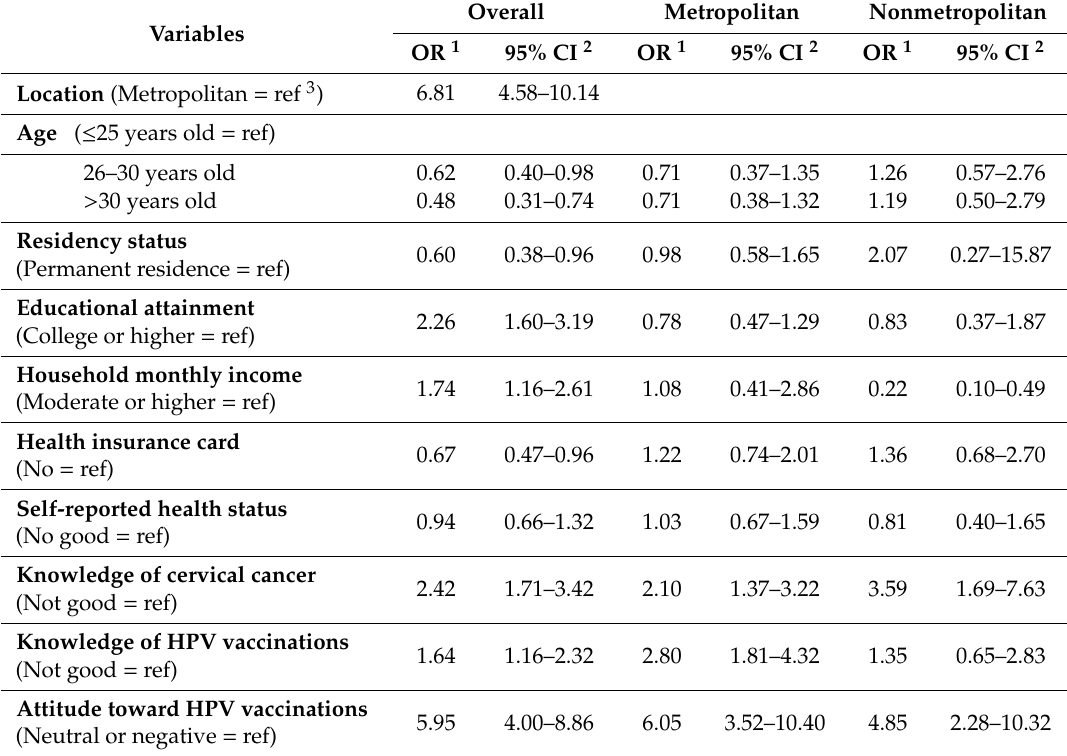
Table 3. Univariate logistic regression for intention to receive the HPV vaccination.